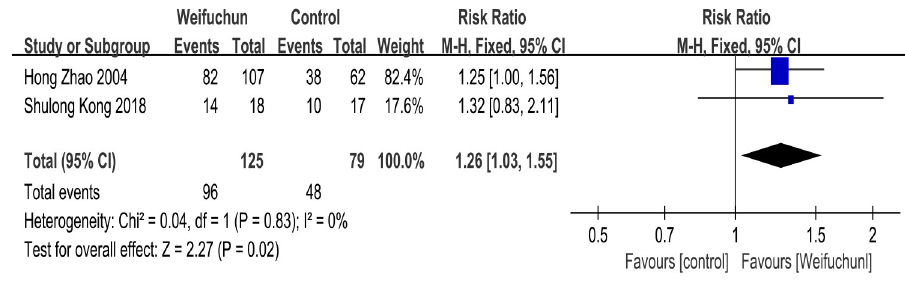
Fig 9. Forest plot of H pylori inhibition